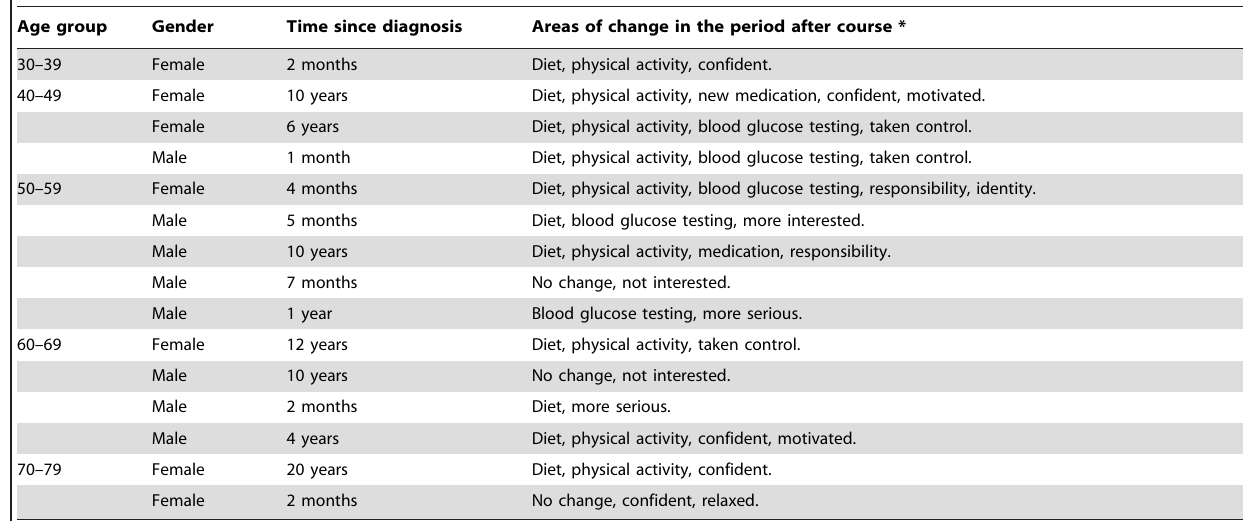
Table 1. Description of participants and type of changes made (only participants in individual interviews, N =15).